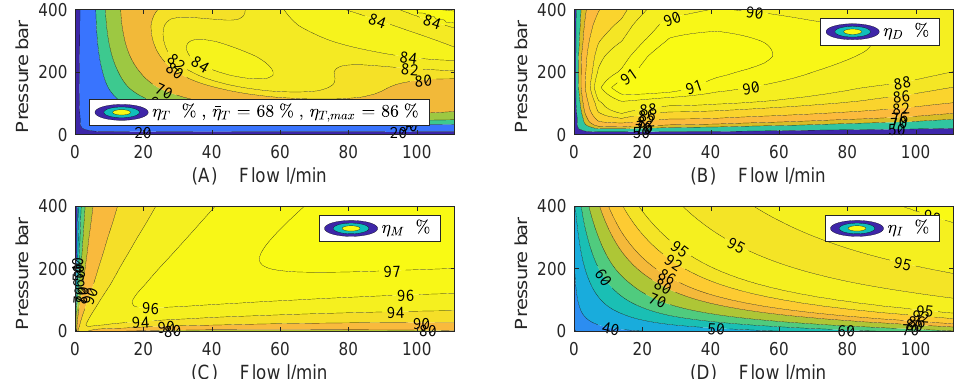
Figure 8. ( A ) Total efficiency of the reference VsD, from inverter inlet to hydraulic outlet; ( B ) displace- ment unit efficiency; ( C ) electric motor efficiency; ( D ) inverter